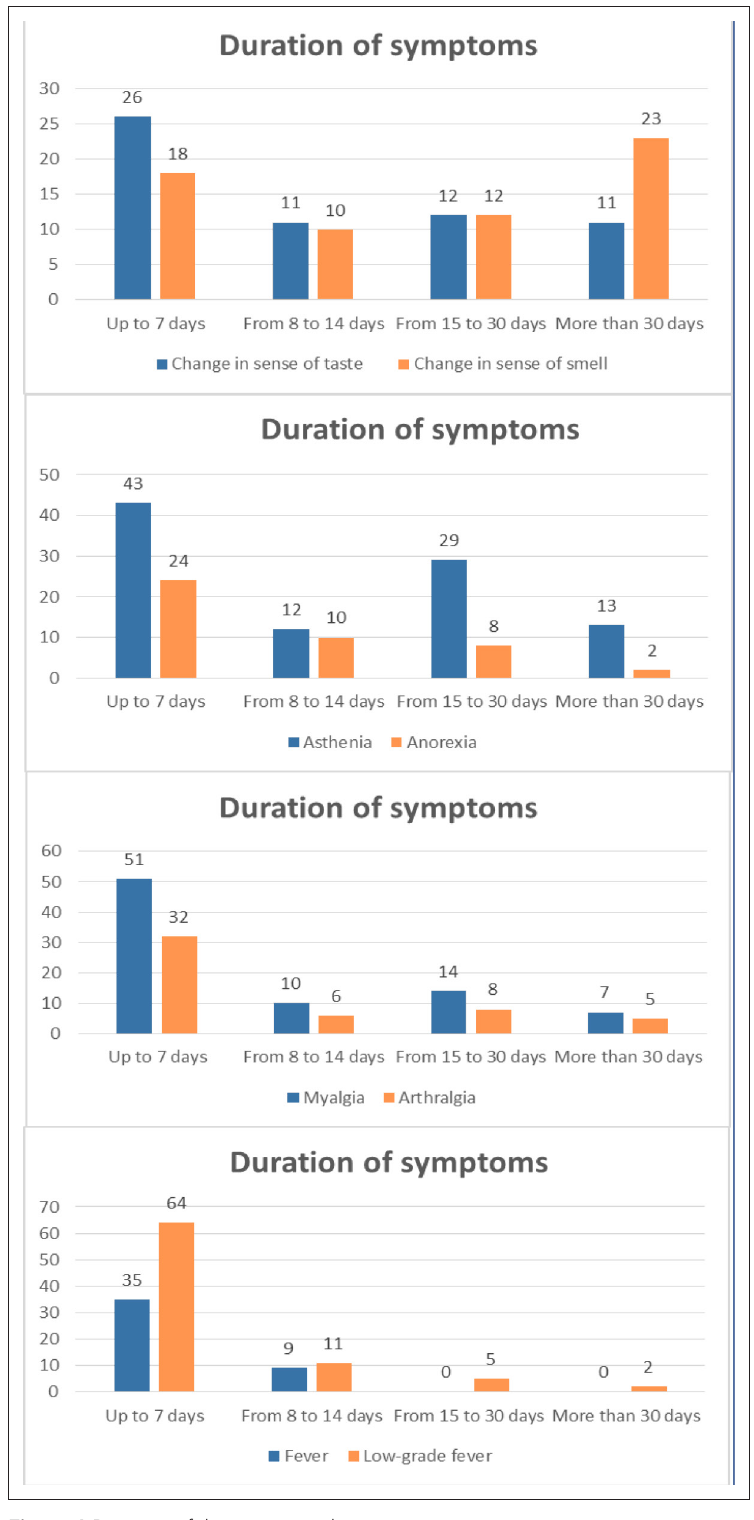
Figure 1 Duration of the most prevalent